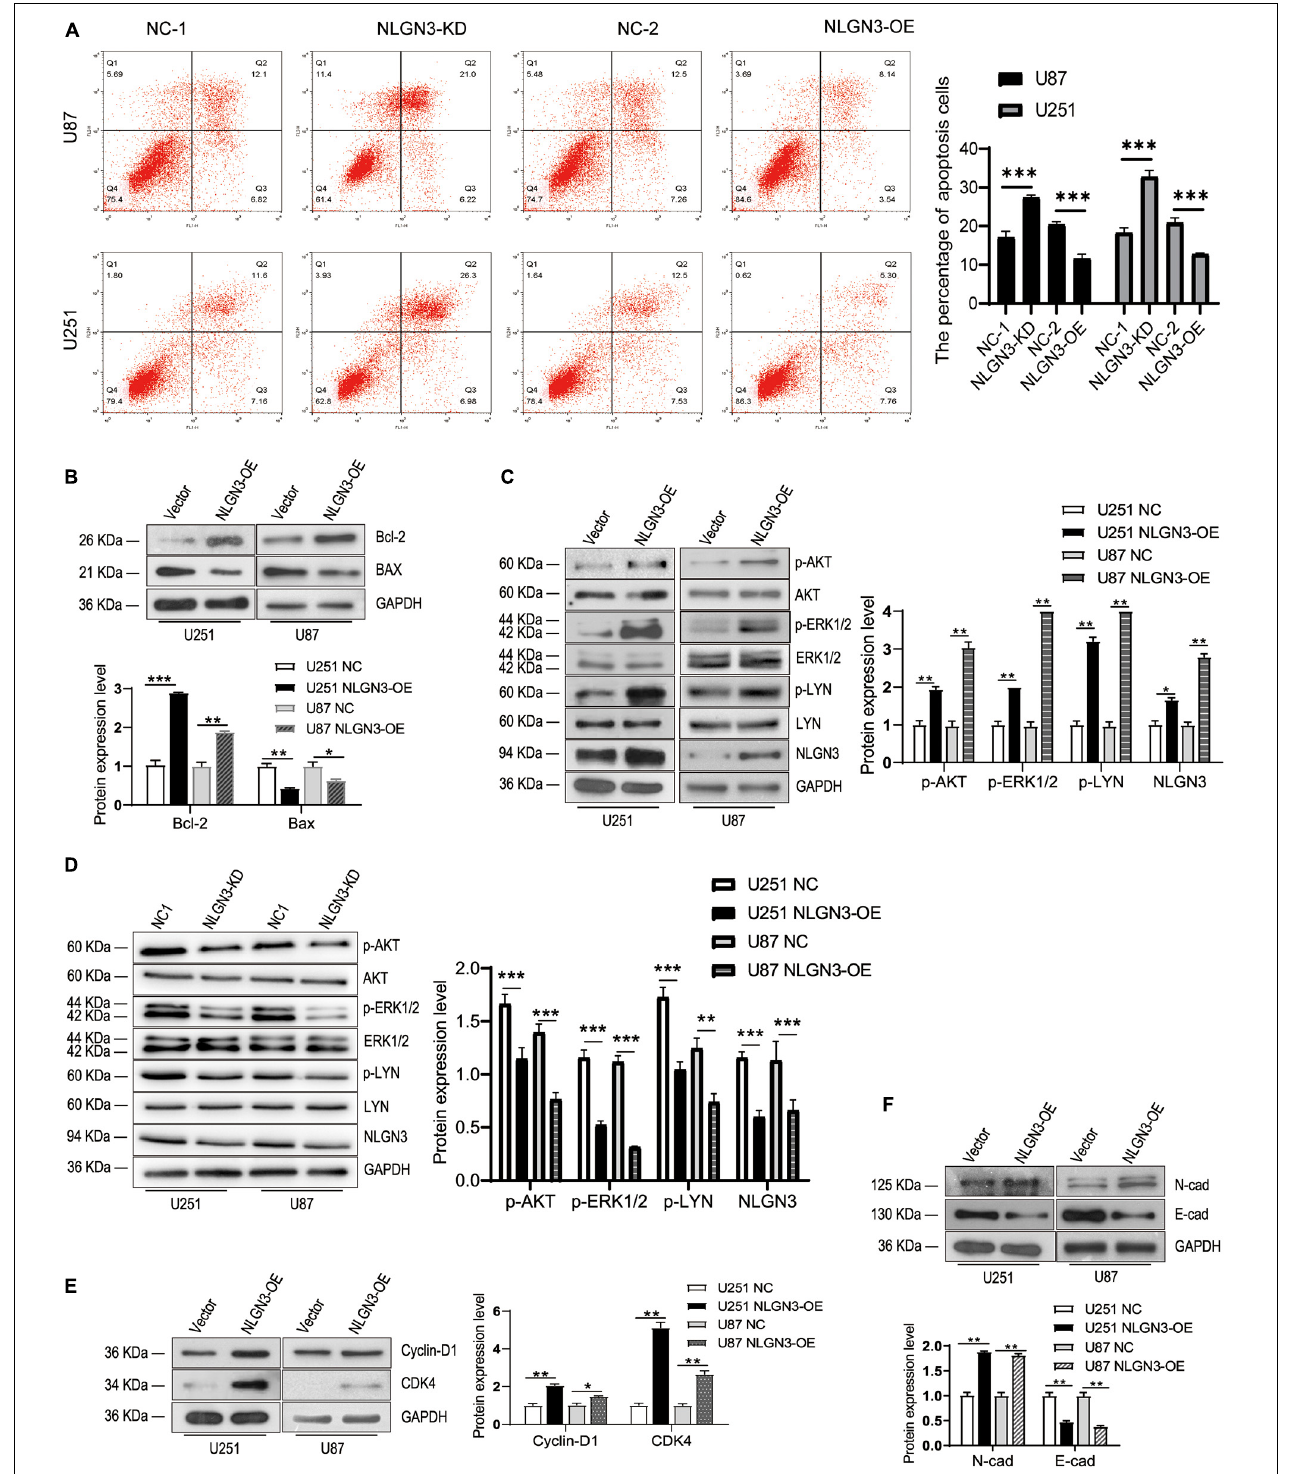
FIGURE 3 | NLGN3 activated the AKT/ERK1/2 pathway and induces the EMT process in glioma cells. (A) The apoptosis was detected by flow cytometry in U87 and U251 cells. Then, the expression levels of NLGN3 downstream proteins were detected by Western blot. (B) NLGN3 upregulated Bcl-2 expression, and downregulated BAX expression. (C,D) NLGN3 upregulated the level of phosphorylation of AKT, ERK1/2, and LYN in U87 and U251 cells. (E) The expression levels of Cyclin-D1 and CDK4 increased in glioma cells with transfection of NLGN3 overexpression plasmid. (F) NLGN3 upregulated N-cad expression and downregulated E-cad expression. * p < 0.05; ** p < 0.01; *** p < 0.001.